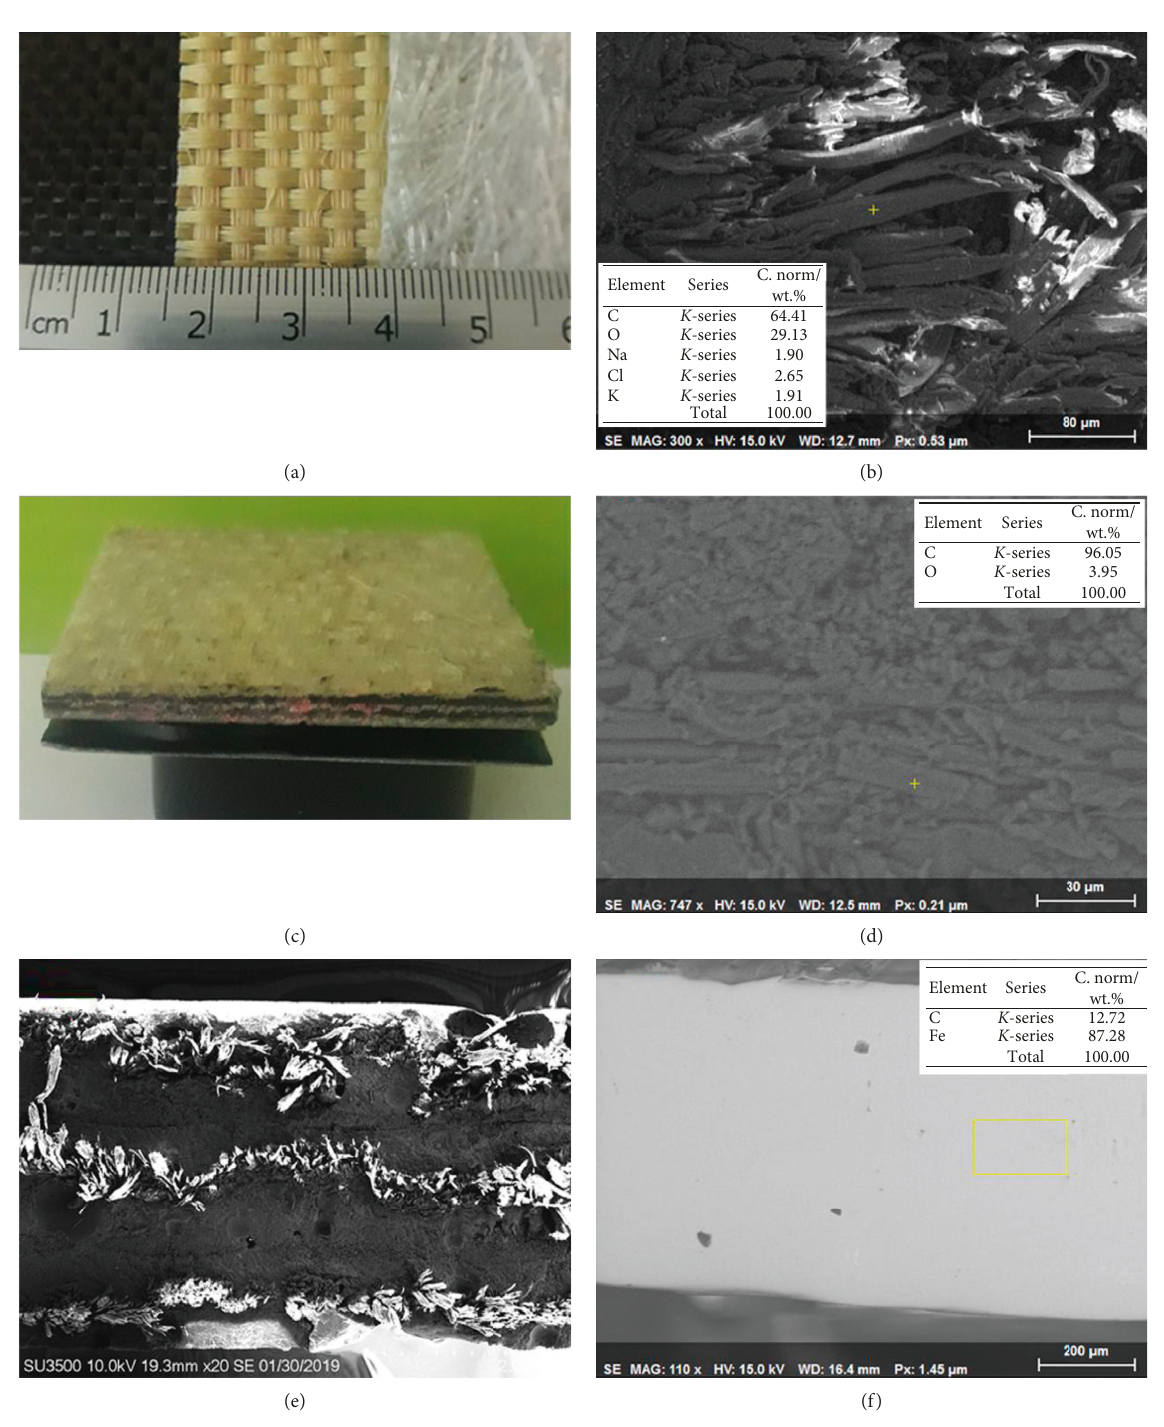
Figure 4: Images of the materials used (a) CF, NHF, and GF, (b) sample 28 and sheet of the roof, (c) SEM of sample 28, (d) morphology and composition of the NHF, (e) morphology and composition of the CF, and (f) morphology and composition of the sheet of